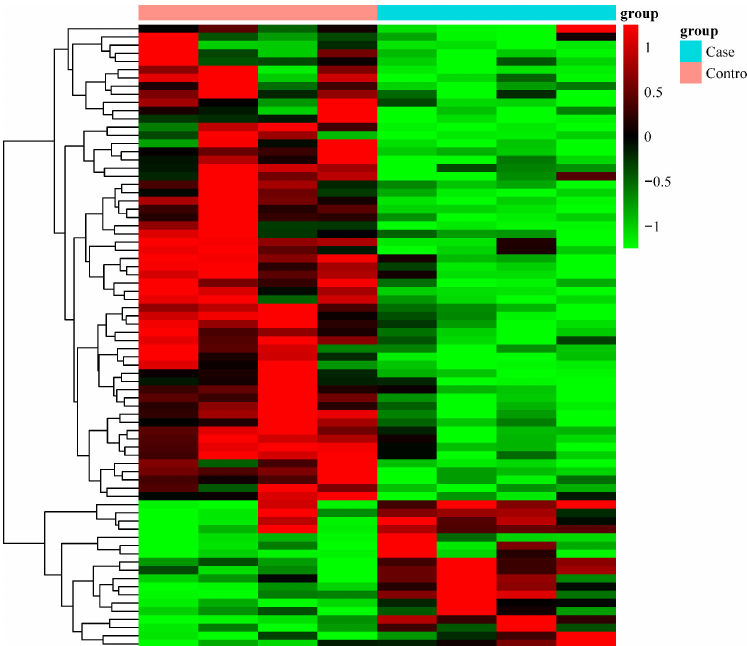
Fig. 2 Hierarchical clustering analysis of the 18 upregulated and 58 downregulated long non-coding RNAs. The fold change and P -value were calculated using the limma package in R.